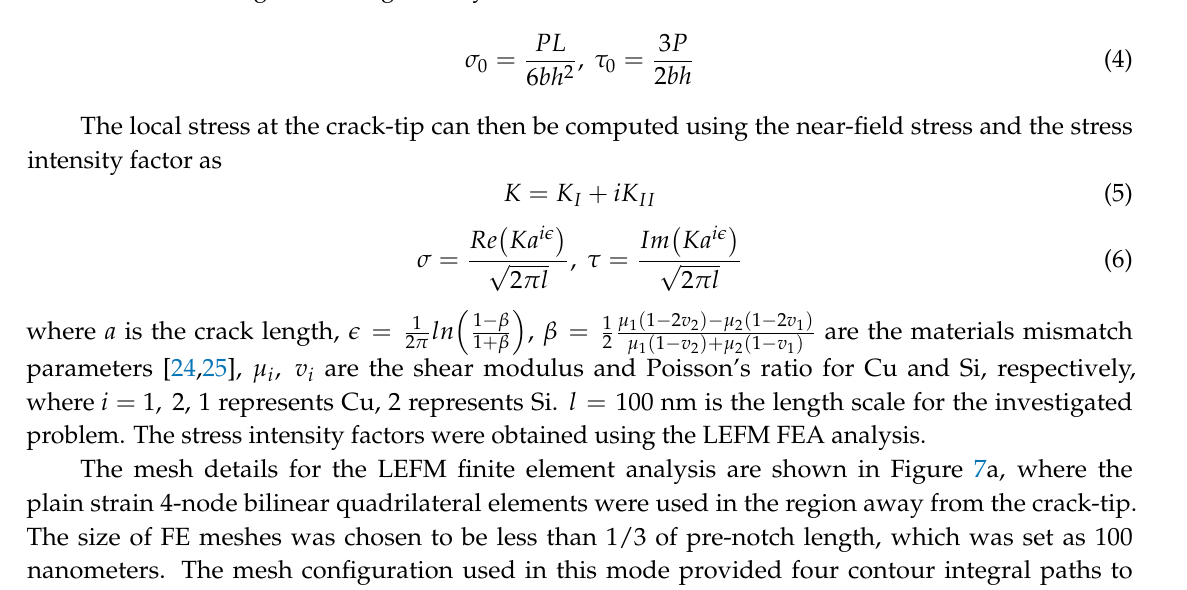
indicates Cu, grey indicates Si), ( c ) normal stress at the crack tip, ( d ) shear stress at the crack tip.